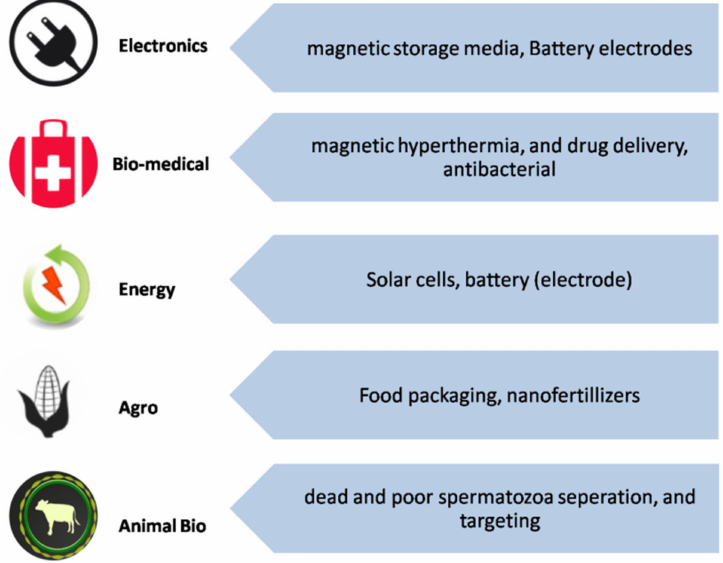
Figure 1. Various applications of iron oxide nanoparticles